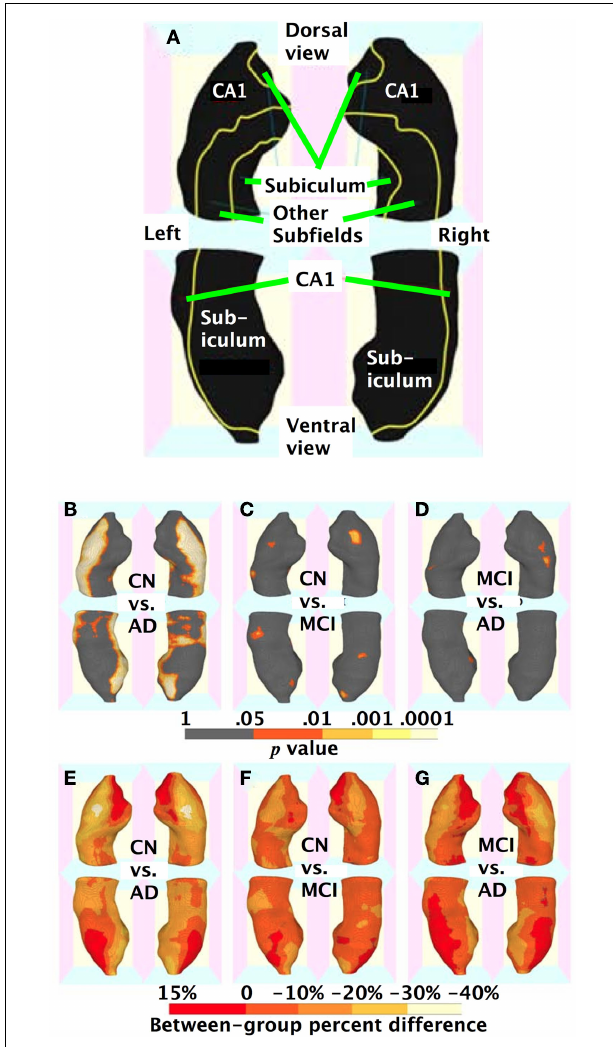
FIGURE 3 |Three-dimensional maps of hippocampal regional atrophy. (A) A schematic representation of the hippocampal subregions mapped onto a representative hippocampal surface (definition of each subregion based on Duvernoy, 2005); (B,E) statistical p -value (corrected for multiple comparison) maps and percent difference maps for cognitively normal (CN) vs. Alzheimer’s disease (AD) comparison; (C,F) for CN vs. mild cognitive impairment (MCI) comparison; and (D,G) for MCI vs. AD comparison of hippocampal radial